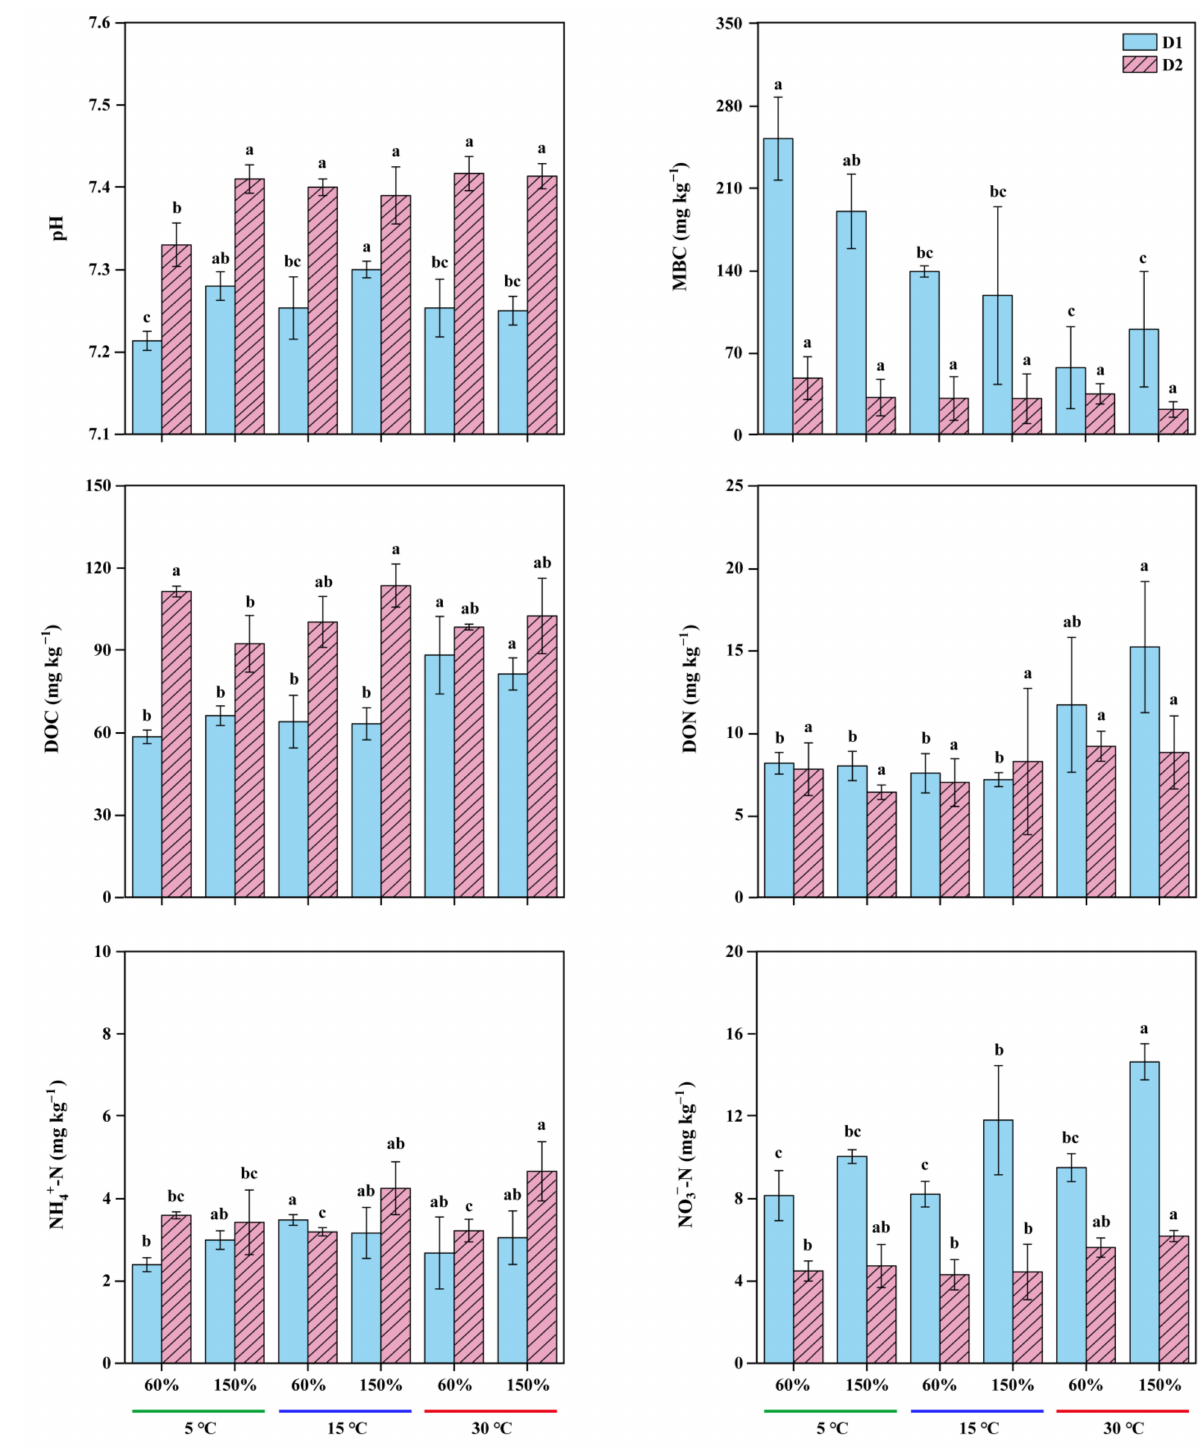
Figure 3. Chemical properties of soil samples after incubation at temperatures of 5, 15, and 30 ◦ C in combination with soil moisture states of 60% and 150% water-filled pore space. The blue and pink bars represent the chemical properties of D1 (surface soil: 0–20 cm) and D2 (subsurface soil: 20–50 cm), respectively. Different lowercase letters indicate significant differences between treatments in each soil layer ( p < 0.05). MBC: microbial biomass carbon; DOC: dissolved organic carbon; DON: dissolved organic nitrogen; NH 4 + -N: ammonium nitrogen; NO 3 − -N: nitrate nitrogen. The pH of the surface soil samples significantly increased with moisture increase when incubated at 5 and 15 ◦ C. The soil NH 4+ -N content at subsurface significantly